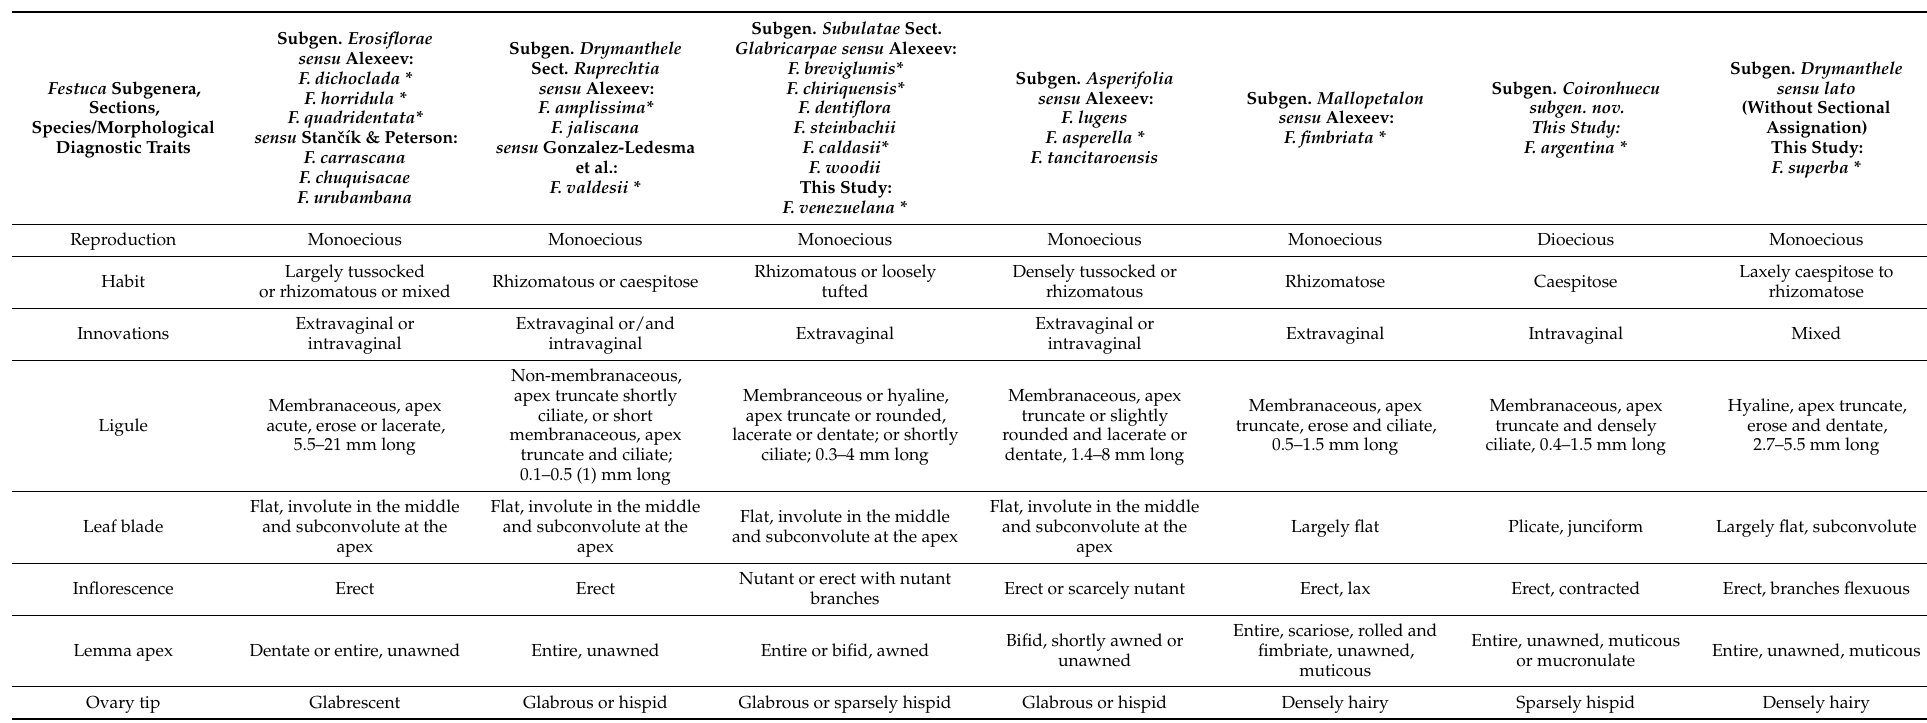
Table 1. Morphological diagnostic traits used to classify species within Festuca subg. Erosiflorae , F . subg. Drymanthele sect. Ruprechtia , F . subg. Subulatae sect. Glabricarpae , F . subg. Asperifolia and F. subgen. Mallopetalon sensu Alexeev and other authors, plus the newly described F . subgen. Coironhuecu subgen. nov . ( F. argentina ) and F . subgen. Drymanthele sensu lato ( F. superba ) analyzed in this study. The type of species of each subgeneric or sectional taxa are highlighted in bold. The asterisks indicate the species used in the phylogenomic